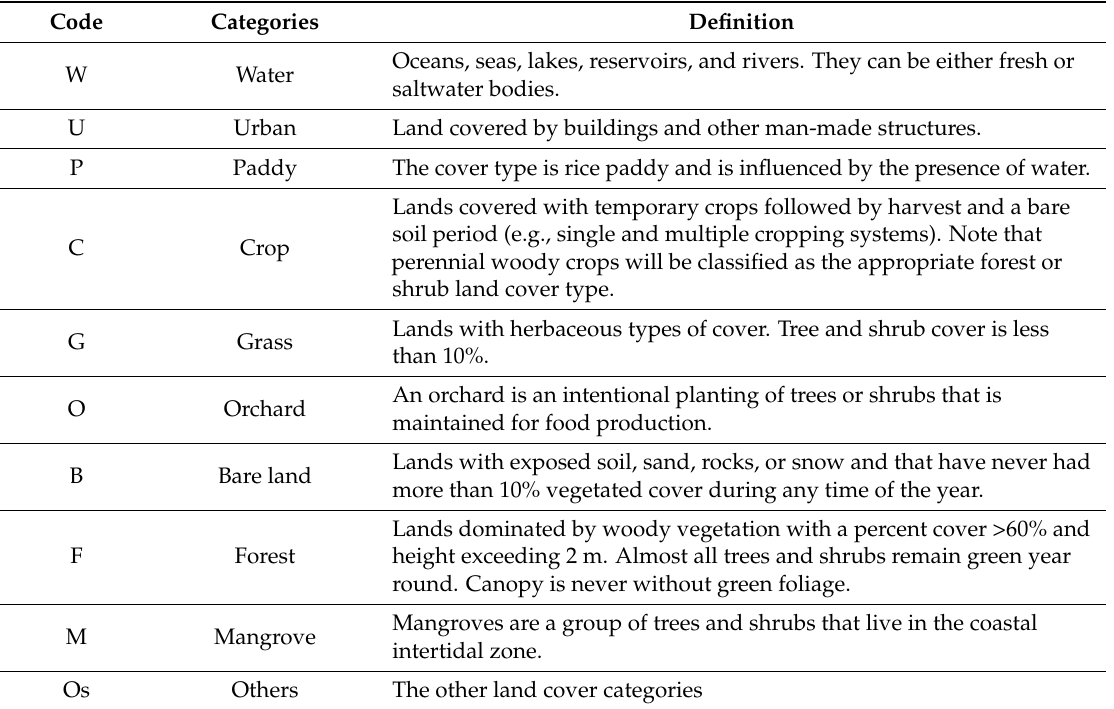
Table 1. Description of the land cover categories of Central Vietnam,